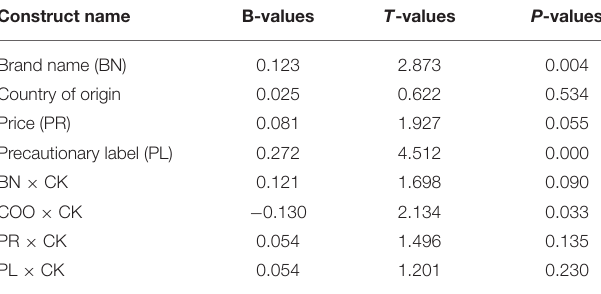
TABLE 10 | Path co-efficient and significance level.